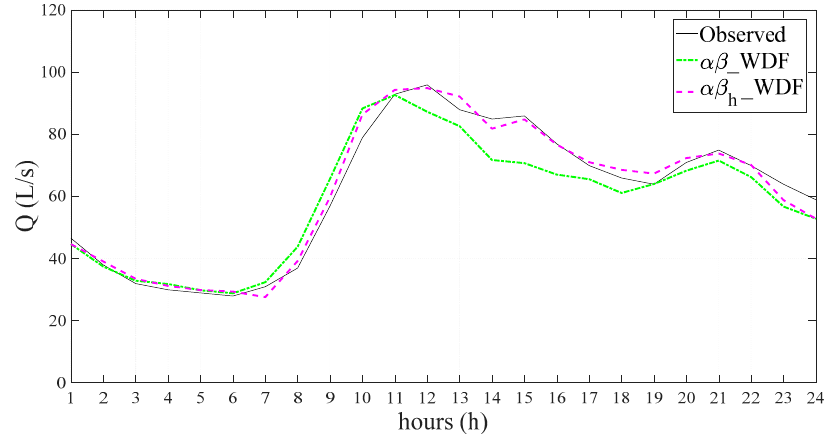
Figure 9. Comparison between the observed water demand pattern for a holiday in the year 2000 (1 May, international workers’ day) and the 1-h-ahead forecasts provided by the αβ _WDF and αβ holiday Water Demand Forecasting ( αβ h _WDF) models. Q is the discharge flowing in the main pipe that connects the tank to the water distribution system, thus representing the total water demand of the network.